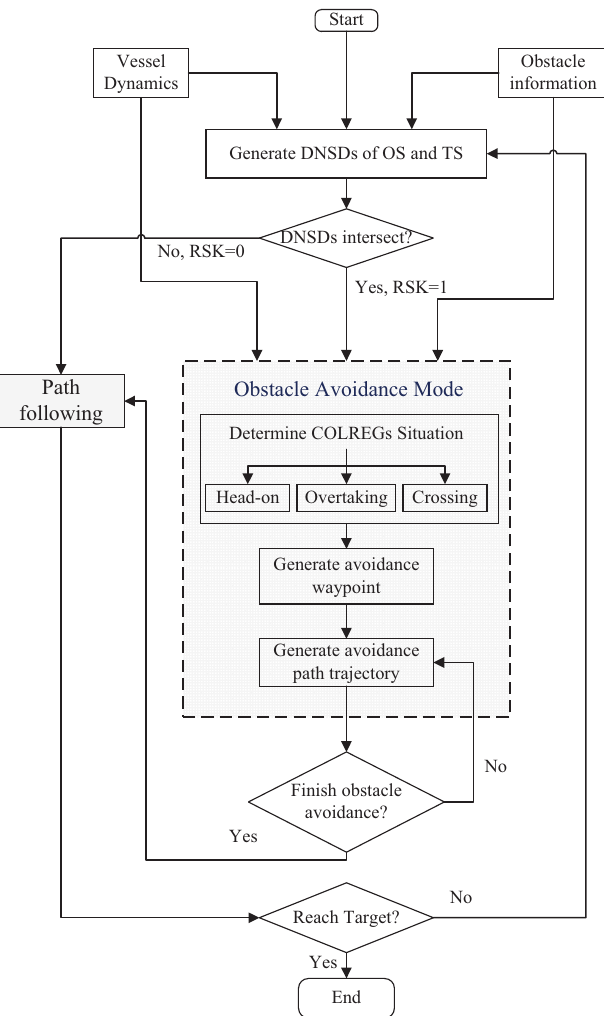
Figure 8. Flowchart of DNSD-based dynamic obstacle